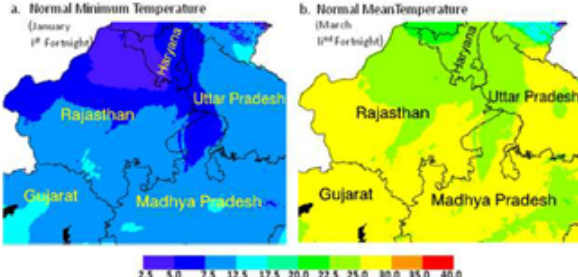
Fig. 7: Normal minimum and mean temperatures over the study